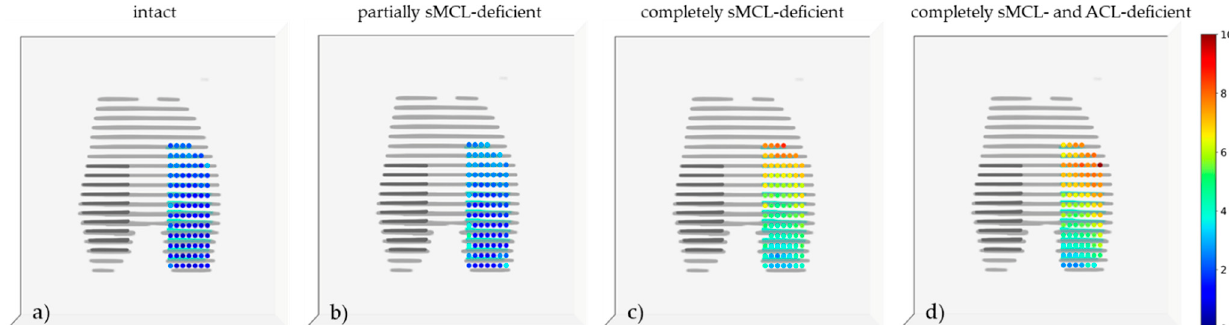
Figure 7. Spatially resolved quantification of medial compartment opening under loading as a function of graded knee joint ligament injury in all knee joints. Displayed are the loading-induced differences in the medial compartment’s subchondral cortical distances (SCD) for the unloaded versus loaded configurations and as a function of joint condition, averaged over all knee joints. ( a ) Intact, ( b ) partial sMCL deficiency, ( c ) complete sMCL deficiency, ( d ) combined sMCL and ACL deficiency. For example, “intact” visualizes the changes of the SCD values of the loaded versus the unloaded configuration. Axial views. Each color-coded dot represents a single SCD measurement along the pre-specified grid. The unit of the continuous colour scale on the right is [mm]. The sliced appearance is due to interslice gaps following axial image reconstruction. Abbreviations and color codes of bone outlines as in Figure 6.